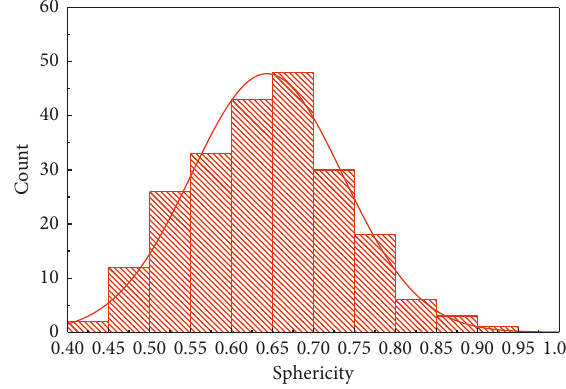
Figure 2: Sphericity distribution of magnetite ore.